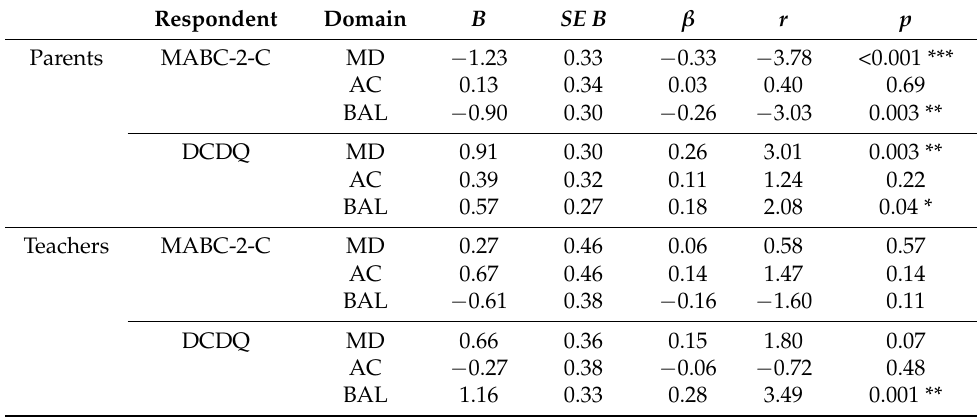
Table 9. Linear regression models of how the scores of parents and teachers’ MABC-2-C and DCDQ reflect three different motor domains as assessed by the Movement ABC-2 Test on children with suspected DCD ( n =